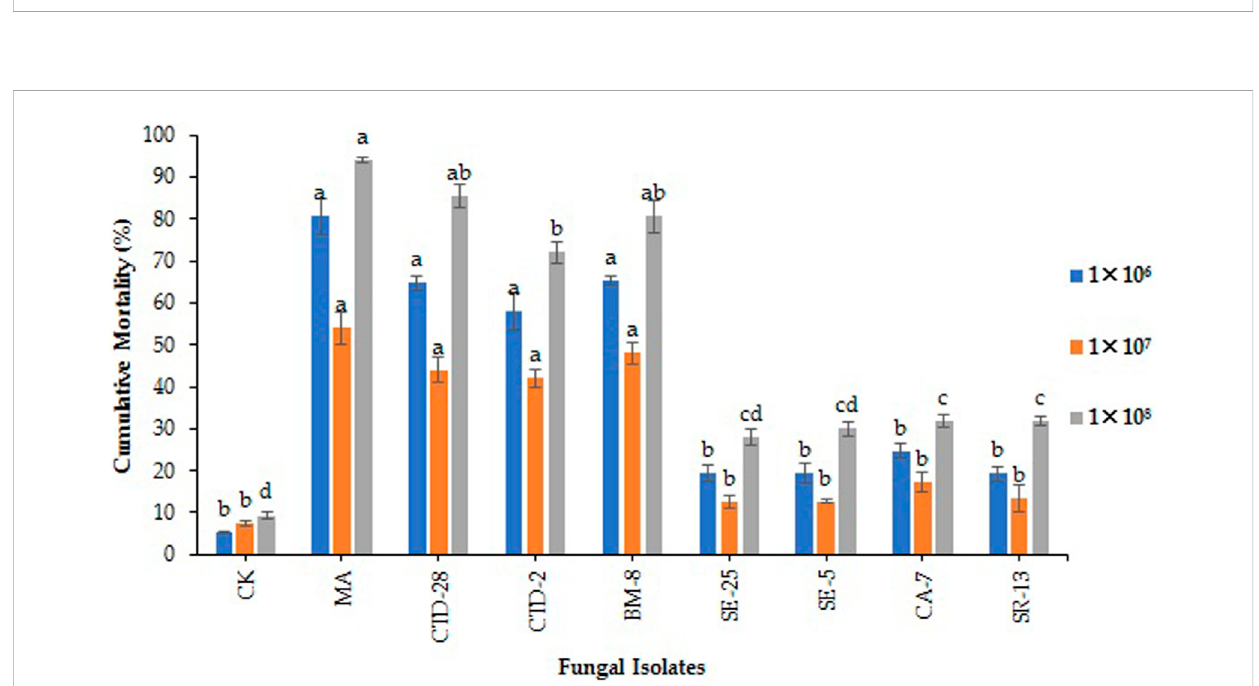
FIGURE 3 Effects of entomopathogenic fungal isolates on cumulative mortality to the eggs and neonates of fall armyworm treated with different concentrationsat14 daysposttreatment.Errorbarsdenotethemean±standarderroratthe95%con fi denceinterval.Meansfollowedbythesameletters are not signi fi cantly different by Tukey ’ s test at p <